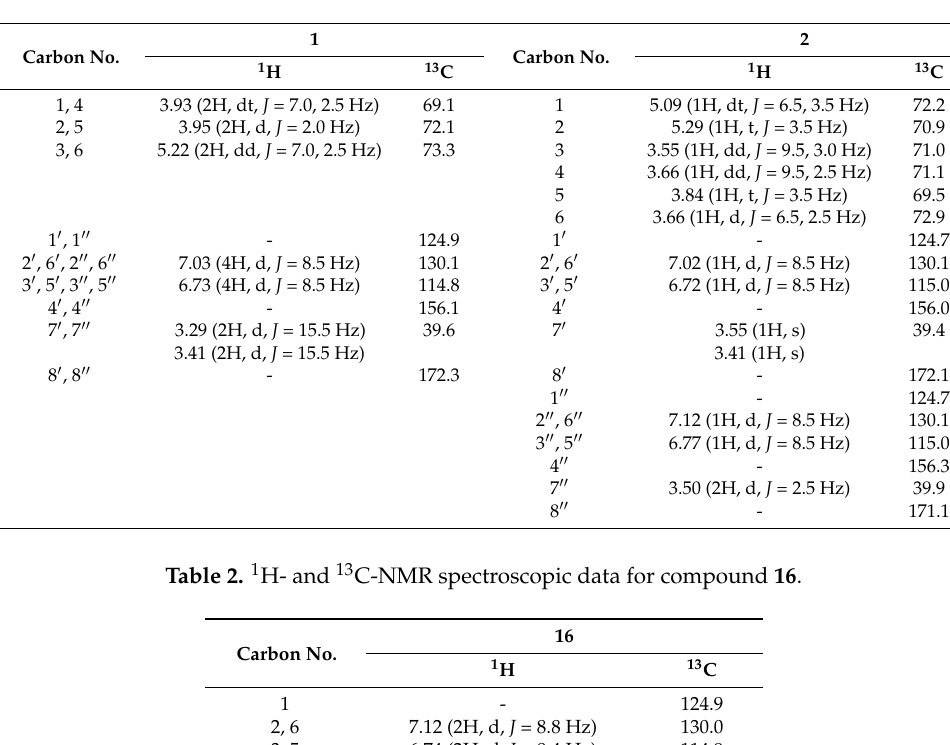
Table 1. 1 H- and 13 C-NMR spectroscopic data for compounds 1 and 2 .